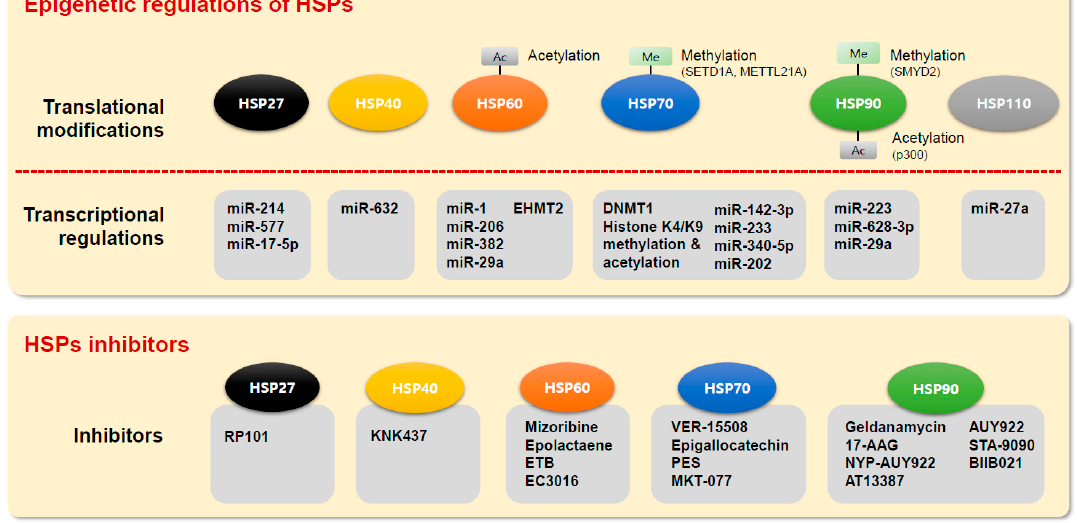
Figure 1. Summary for epigenetic regulations and inhibitors of HSPs in cancer. HSP27 inhibitor RP101 [87]; HSP40 inhibitor KNK437 [88]; HSP60 inhibitors mizoribine [89], epolactaene [90], ETB